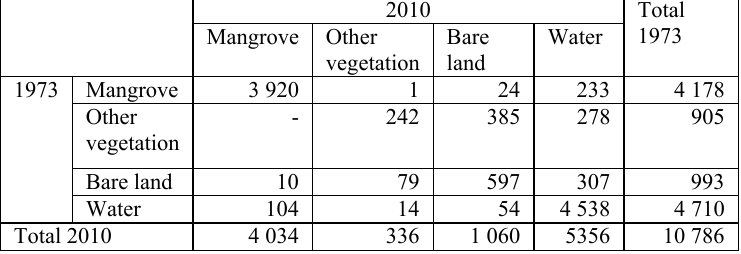
Table 3. Land cover change matrix in Sundarbans forest regions (1973-2010, Bangladesh part), area in sq. km